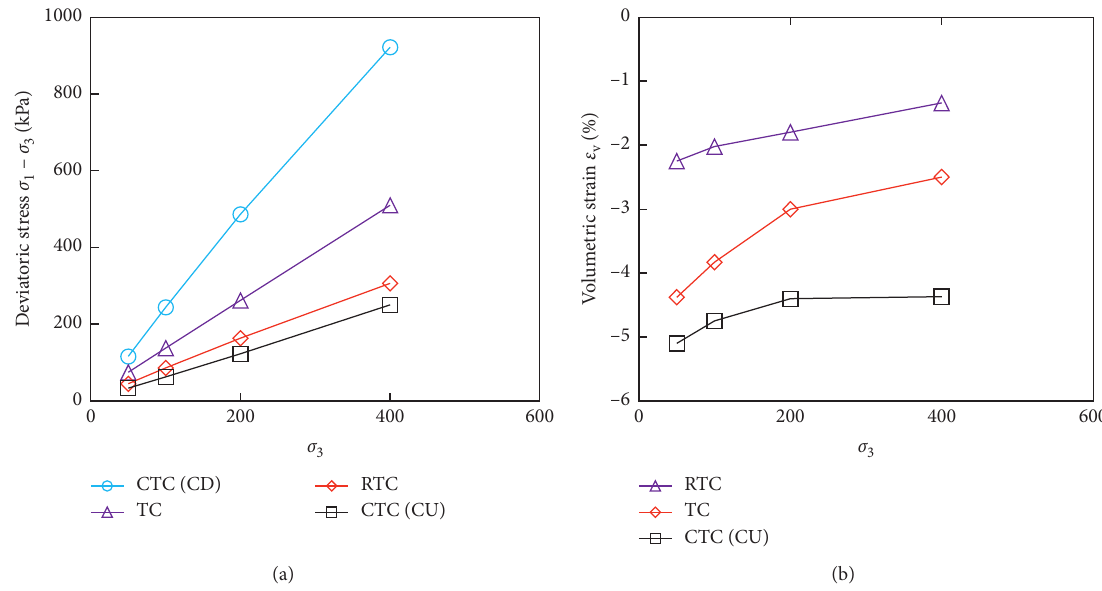
Figure 8: Relationship between σ f and stress path and that of stress path and ε vf of gravelly sand under T 1, T 2, T 3, and T 4. (a) Peak stress under T 1, T 2, T 3, and T 4 paths. (b) Peak volume strain under T 1, T 2, and T 3 paths.